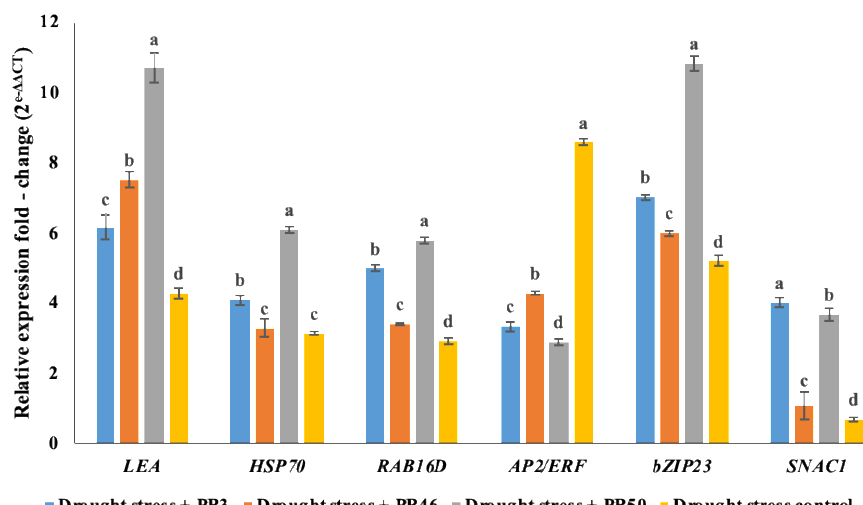
Figure 2. Bar graph of the relative gene expression of LEA , HSP70 , RAB16B , AP2/ERF , bZIP23 , and SNAC1 in 70-day-old rice plants under different treatment conditions. Shown are means and standard deviation values (n = 4). Values with different letters are significantly different according to Duncan’s test ( p ≤ 0.05).